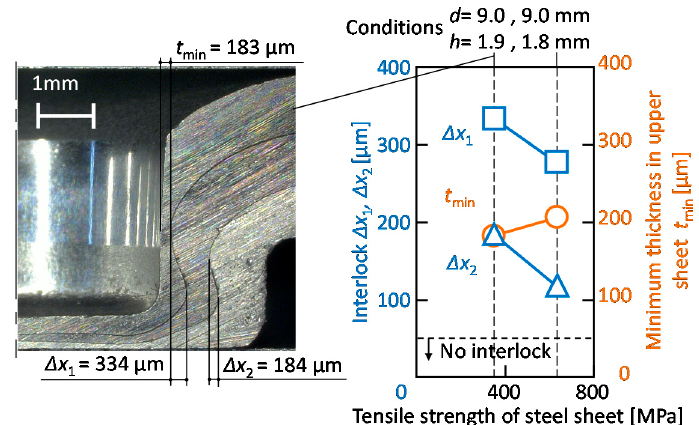
Figure 26. Effect of the tensile strength of the steel sheet on the interlocks and the minimum thickness in the upper sheet.